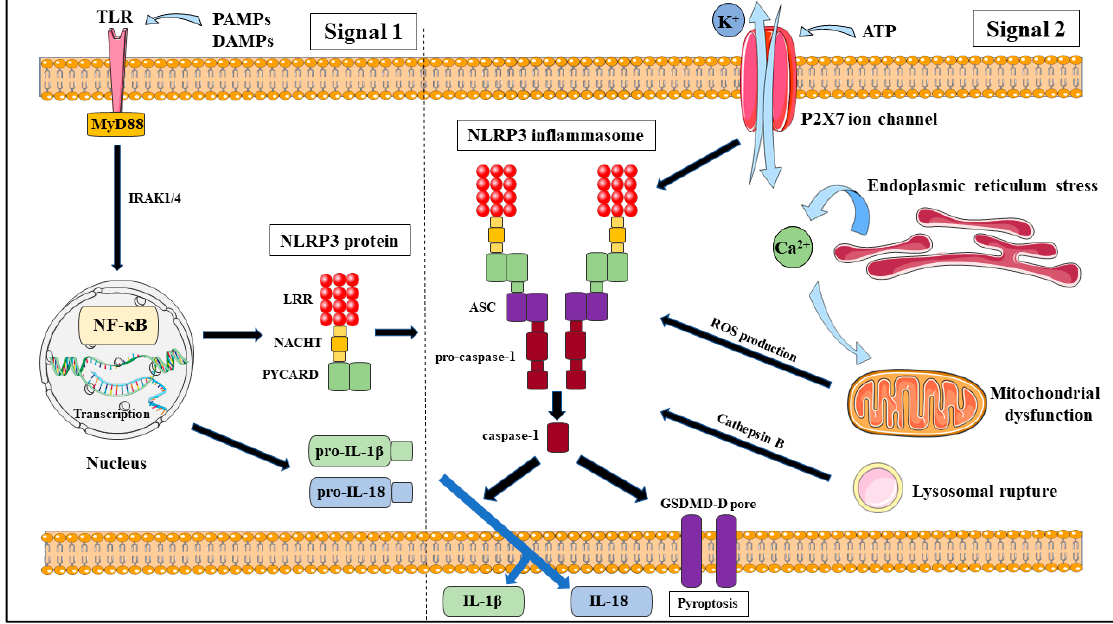
Figure 1. Canonical activation pathway of nod-like receptor ( NLR)P3 inflammasome.